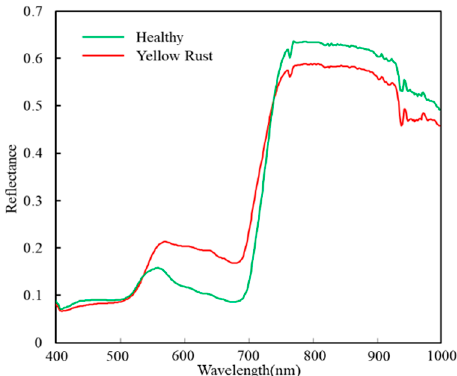
Figure 4. The curves of average spectral reflectance of all healthy and yellow rust-infected samples obtained from seven experiments.